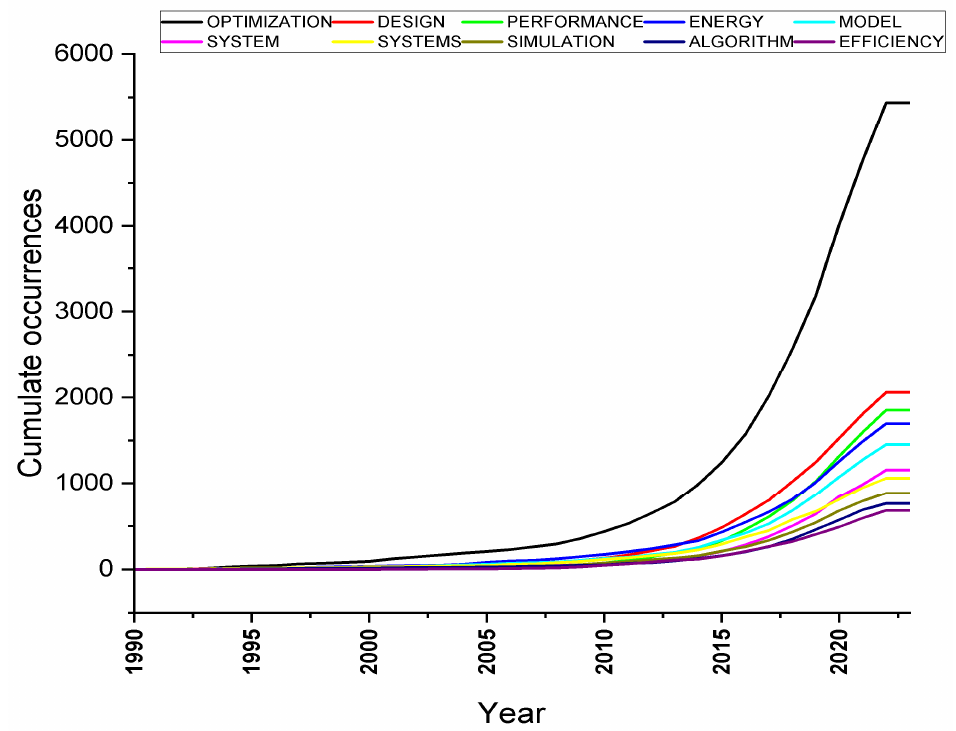
Figure 12. Growth of the top 10 keywords.